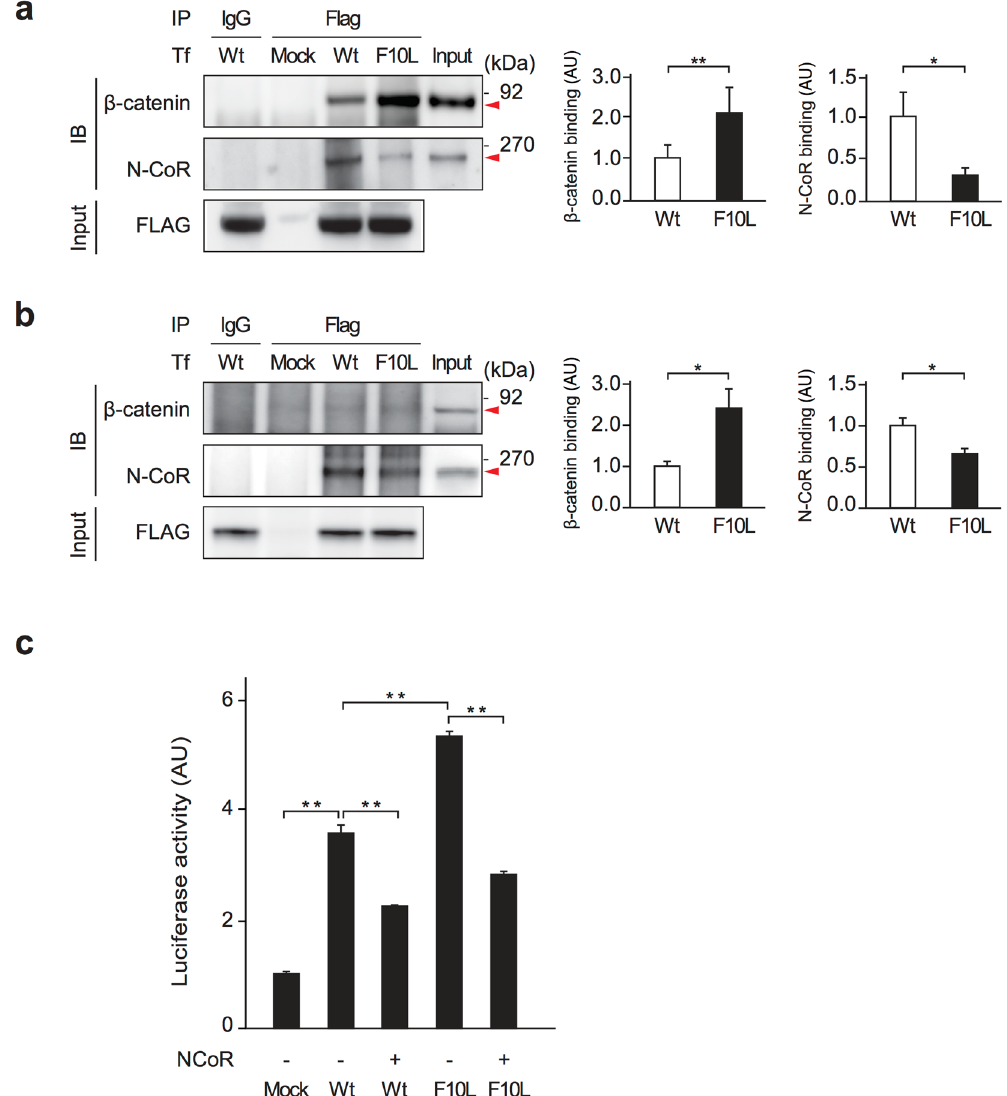
Figure 2. The effect of the Phe10Leu mutation (F10L) on the protein interaction of TBL1XR1 with N-CoR and β -catenin as well as Wnt/ β -catenin transcription activity. ( a,b ) Interaction of wild-type and F10L mutant TBL1XR1 (TBL1XR1 Phe10Leu ) with endogenous N-CoR and β -catenin was assessed in 293FT cells and HT22 hippocampal neuronal cells by co-immunoprecipitation experiments. TBL1XR1 Phe10Leu displays stronger binding with β -catenin compared to wild-type TBL1XR1 (red arrowhead in top panel), while the binding of TBL1R1 Phe10Leu and N-CoR is weaker than that of wild-type TBL1XR1 (red arrowhead in middle panel) ( * P < 0.05 and ** P < 0.01). The inputs of each protein are also shown (bottom panel). Full immunoblots are presented in Supplementary Figure. ( c ) The TOPFlash Wnt reporter assay showed that overexpression of wild-type TBL1XR1 increased Wnt transcription activity, which was further enhanced by an F10L mutation in TBL1XR1 ( * P < 0.05 and ** P < 0.01). Overexpression of N-CoR suppresses an increase in Wnt transcriptional activity induced by either wild-type TBL1XR1 or F10L mutant ( ** P < 0.01). Luciferase activities were determined 48 hours post-transfection and normalized against Renilla values. Bars represent averages of each group in three independent experiments. AU, arbitrary unit. All data are presented as the mean ±